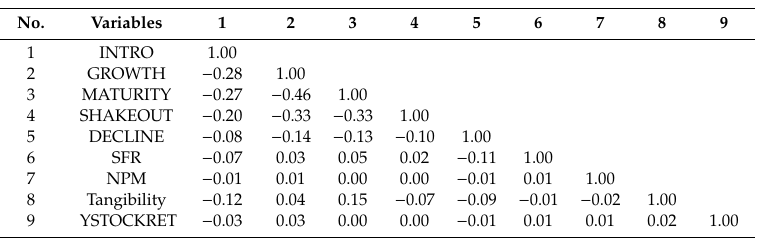
Table 4. Correlation Matrix.